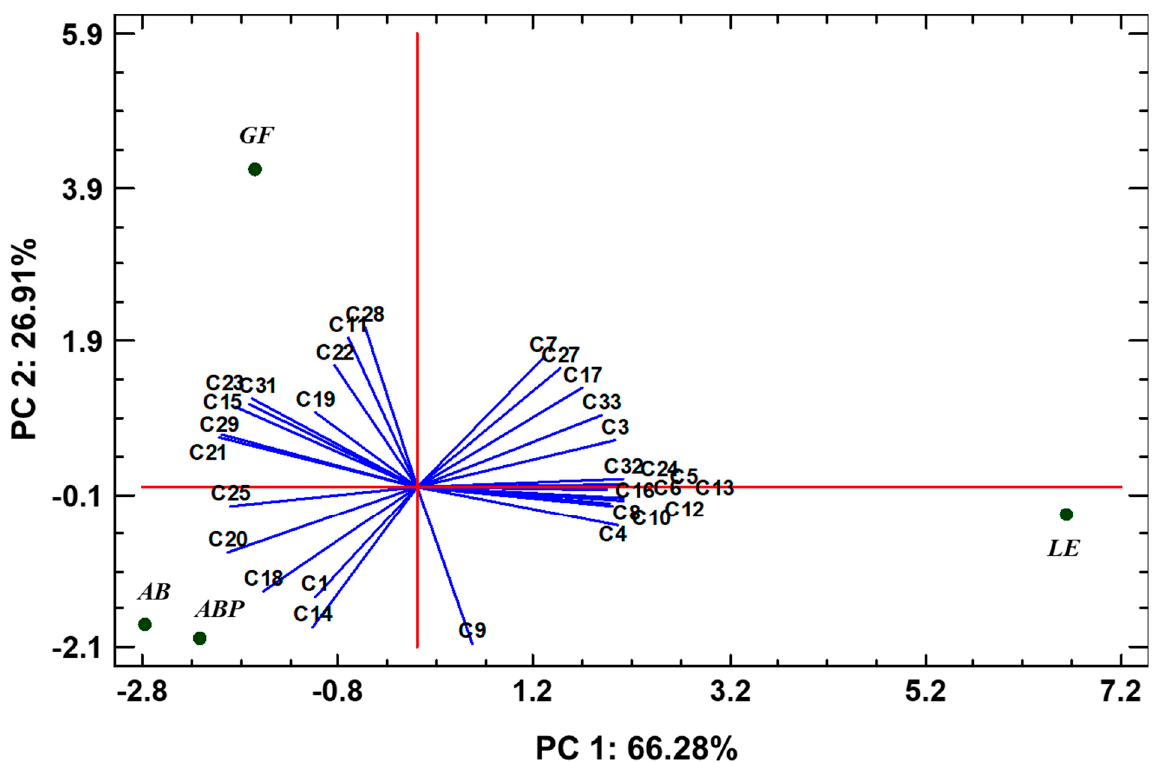
Figure 4. Multivariate analysis (principal component analysis) corresponding to the most-abundant volatile compounds in the freeze-dried mushroom samples detected by GC-MS (AB, Agaricus bisporus sp. bisporus ; ABP, Agaricus bisporus sp. brunnescens ; LE, Lentinula edodes ; GF, Grifola frondosa ). Most-abundant VOCs represented: C1: 2-Propanone; C3: Butanal-3-methyl; C4: Butanal-2-methyl;